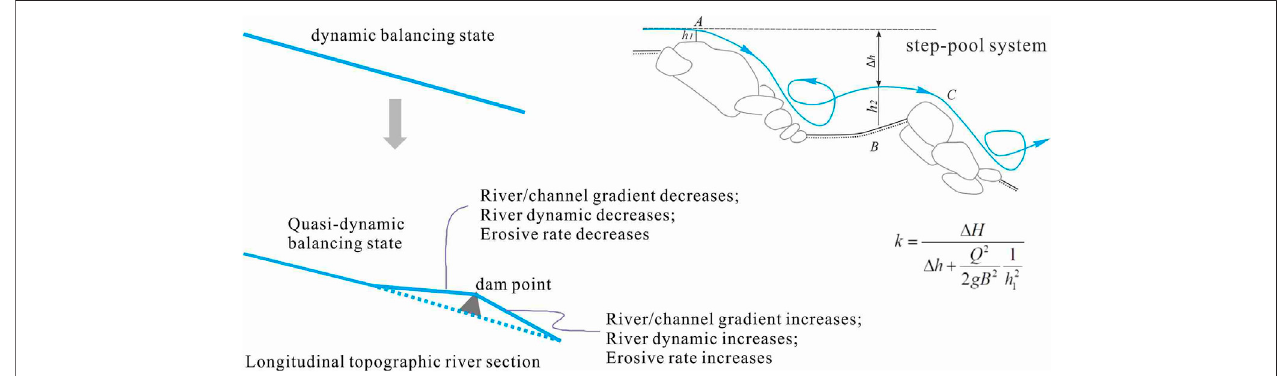
FIGURE 6 | Energy dissipation in a dammed river. Energy dissipation k = Δ H/( Δ h + Q 2 /2gB 2 h 12 ), where Δ h is the difference between two surface elevations from point A to point C, Q is the water fl ow, B is the width of the river, and h 2 is the depth of the water (Xu and Wang, 2004).